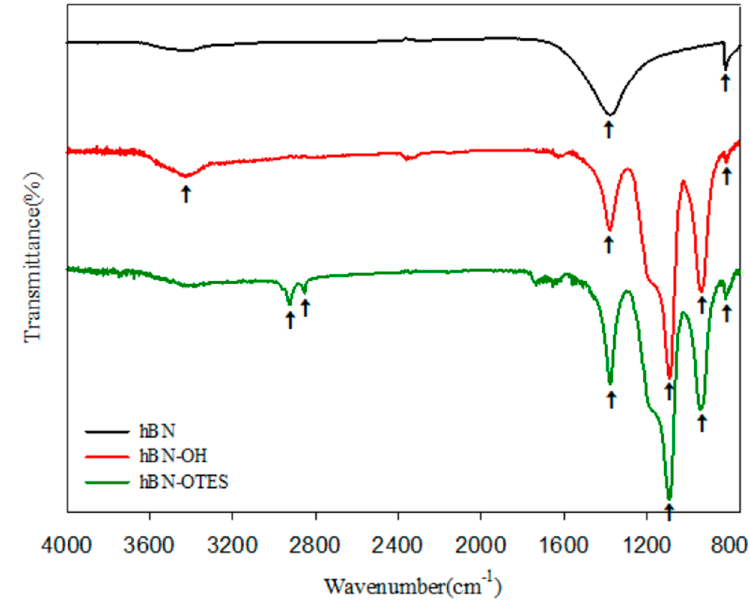
Figure 2. FT-IR spectra of hexagonal boron nitride (hBN), hBN-OH and hBN-OTES (octyltriethoxysilane).